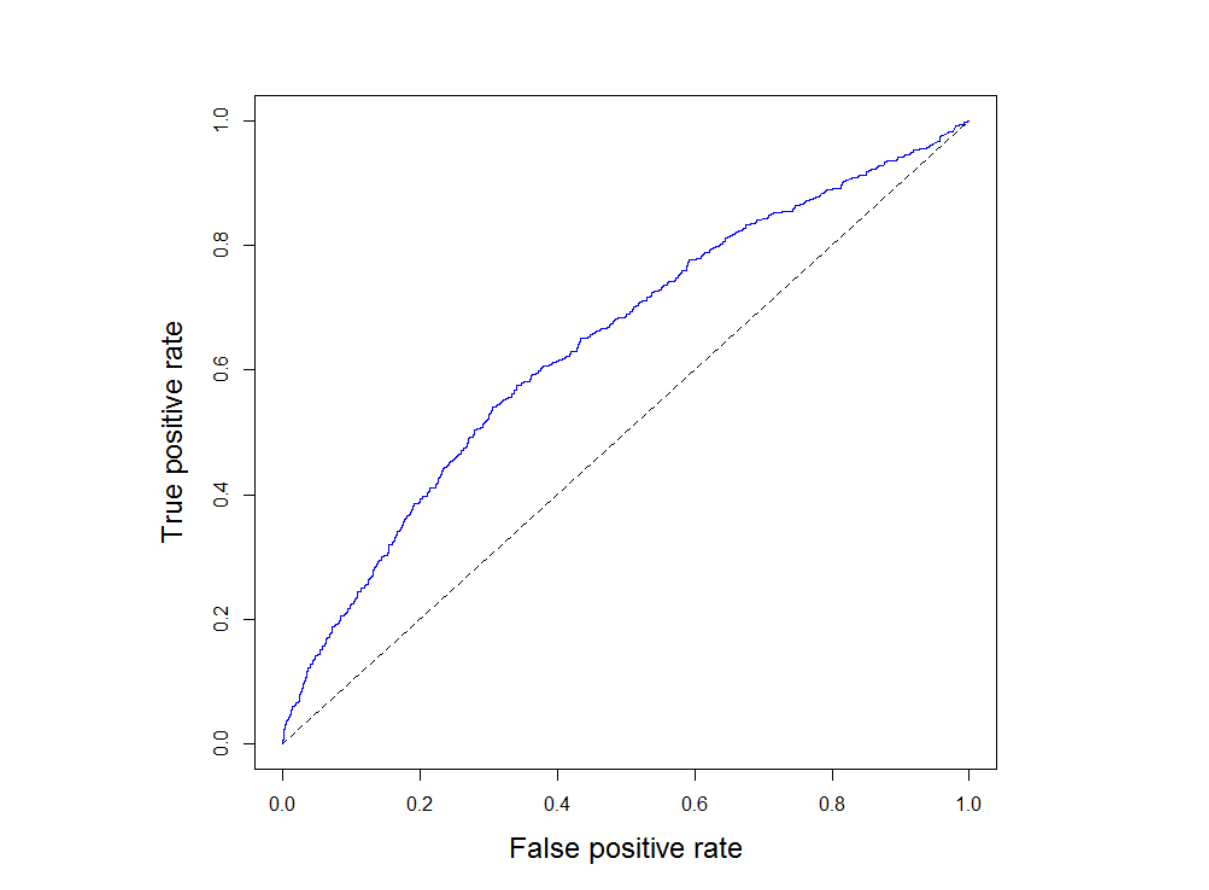
Figure 12. ROC curve obtained on the InCHIANTI